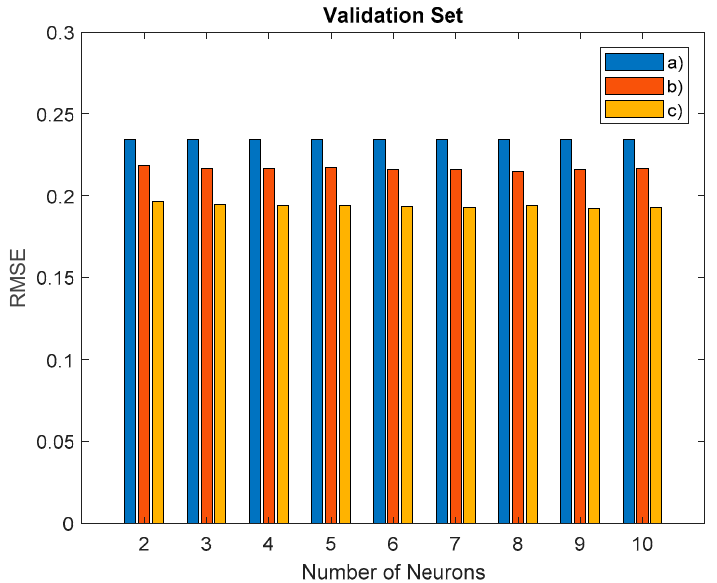
Figure 3. Root mean square errors (RMSEs) of the scaled photovoltaic (PV) power for ( a ), ( b ) and ( c ) model configurations.